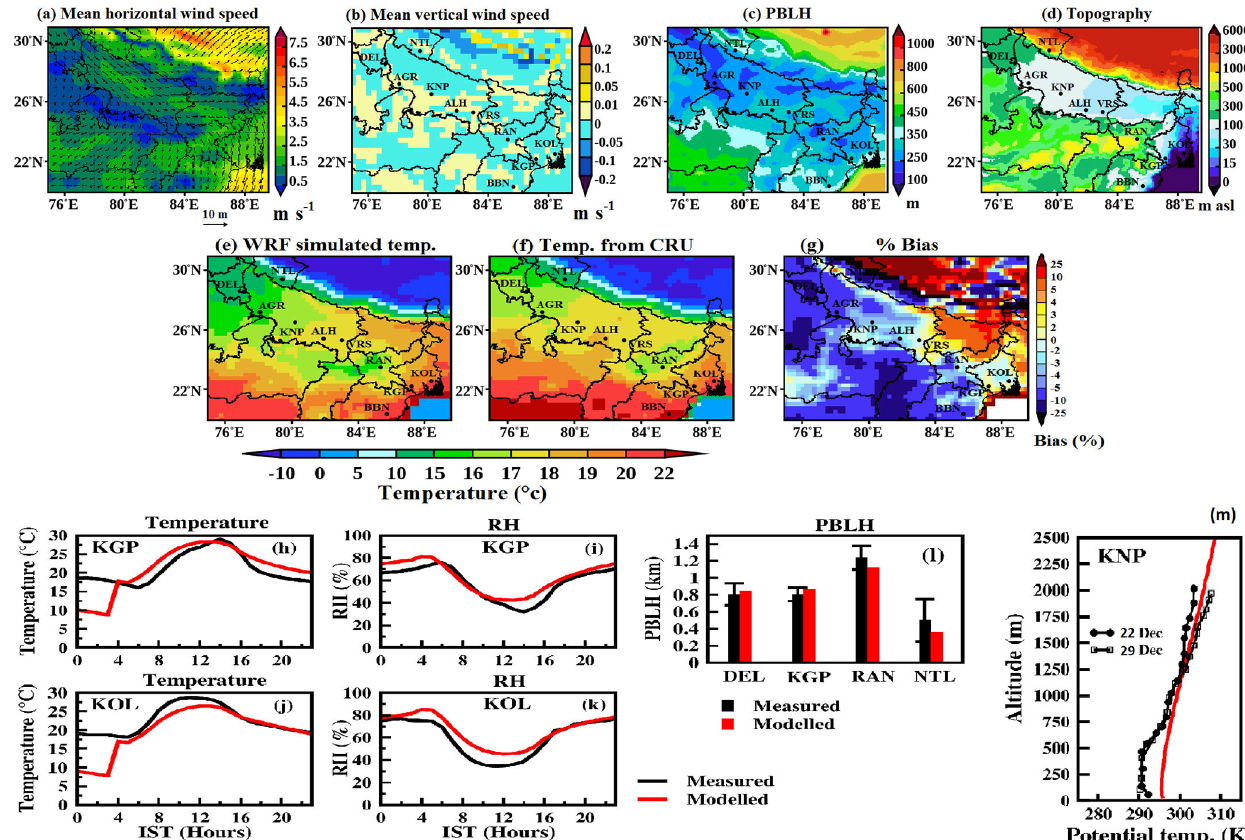
Figure 2. Spatial distribution of the WRF-simulated (a–c) winter monthly mean (a) horizontal wind field (note that the colour scale is for wind speed in ms − 1 and the arrows indicate the direction of the mean field), (b) vertical wind speed at 1000hPa, (c) planetary boundary layer height (PBLH in metres), and (d) topography (metres above sea level, ma.s.l.) (e–g) Spatial distribution of winter monthly mean surface temperature from (e) WRF simulations, (f) observations from CRU, and (g) percentage bias in WRF estimates. (h–k) Comparison of the hourly distribution of winter monthly mean (h, j) surface temperature and (i, k) relative humidity from WRF simulations with observations at stations (Kharagpur, KGP; Kolkata, KOL). (l) Comparison of winter monthly mean PBLH during day hours between measured and simulated values at the stations under study. The error bars represent the standard deviation ( σ ) in the measured PBLH. (m) Comparison of the vertical profile of potential temperature obtained from WRF (winter monthly mean) and measurements